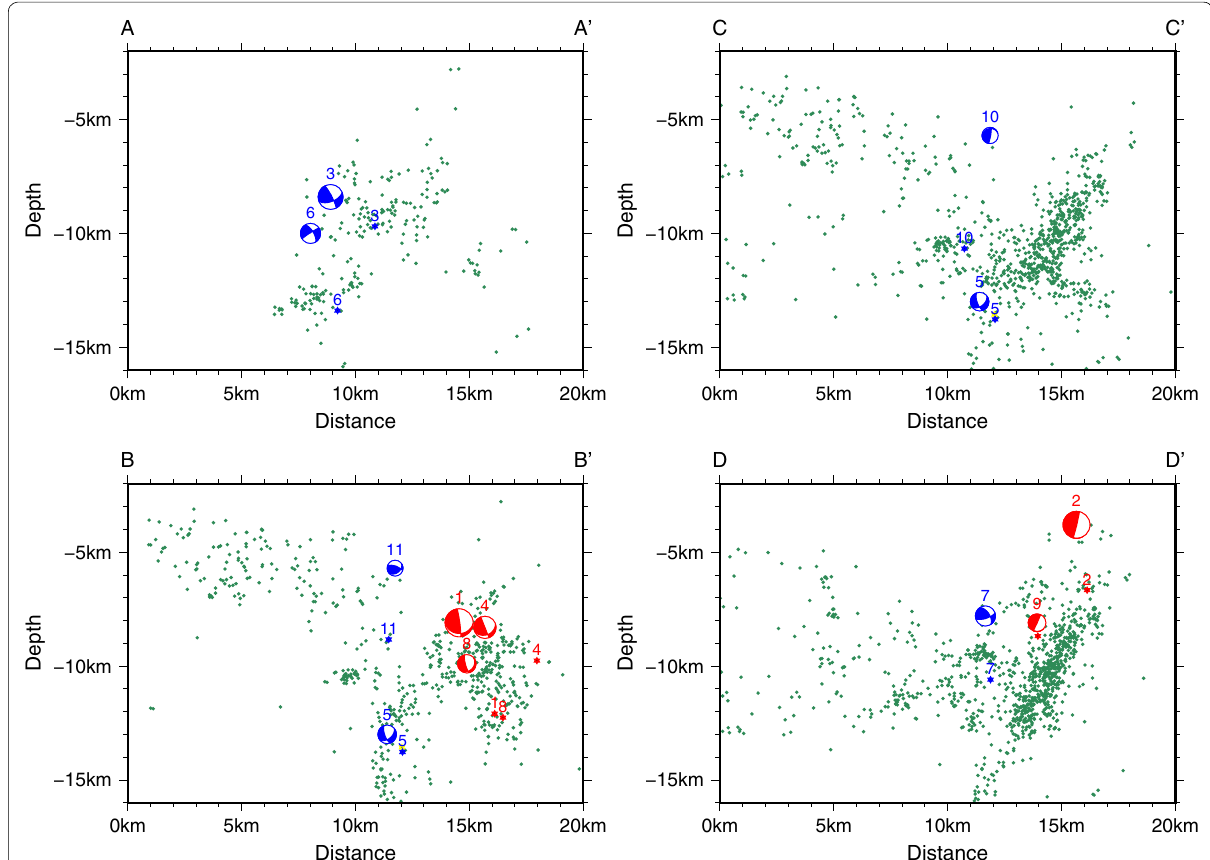
Fig. 9 Vertical cross sections with inferred CMTs (beach-balls) and relative locations (green dots) of earthquakes adopted from Kato et al. (2016). For events coloring and cross-sectional placement, see Fig. 8. Events shown in the cross sections are taken from volume spreading 5 km on each side of the cross-sectional plane. Events are numbered according to Table